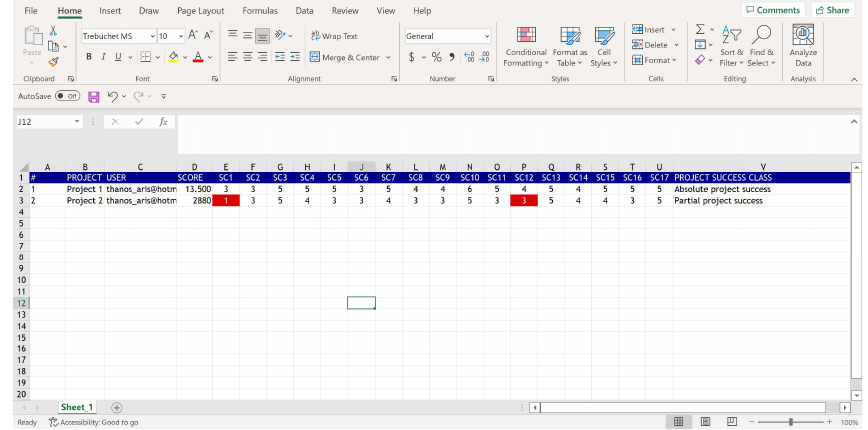
Figure 4. The extracted excel file including the project success evaluation